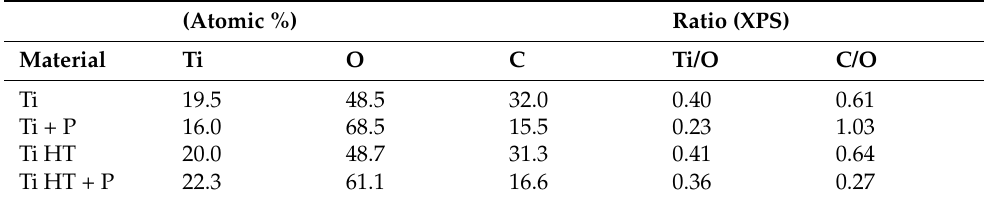
Table 2. Chemical composition of the surface of materials examined by XPS. (Atomic %) Ratio (XPS) Material Ti O C Ti/O Ti Ti +